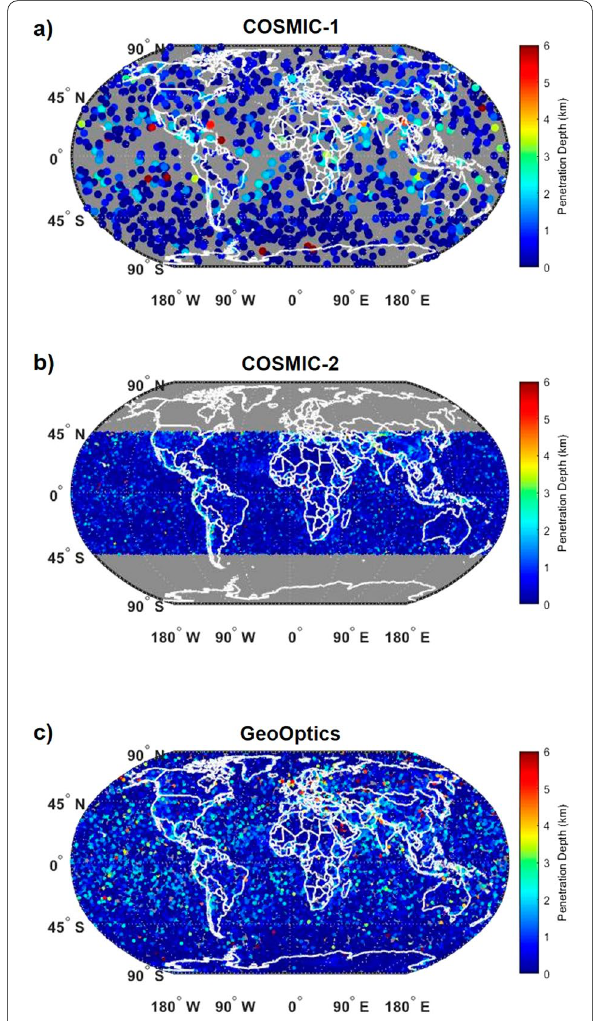
Fig. 2 Penetration depth maps. a COSMIC-1, b COSMIC-2, c GeoOptics